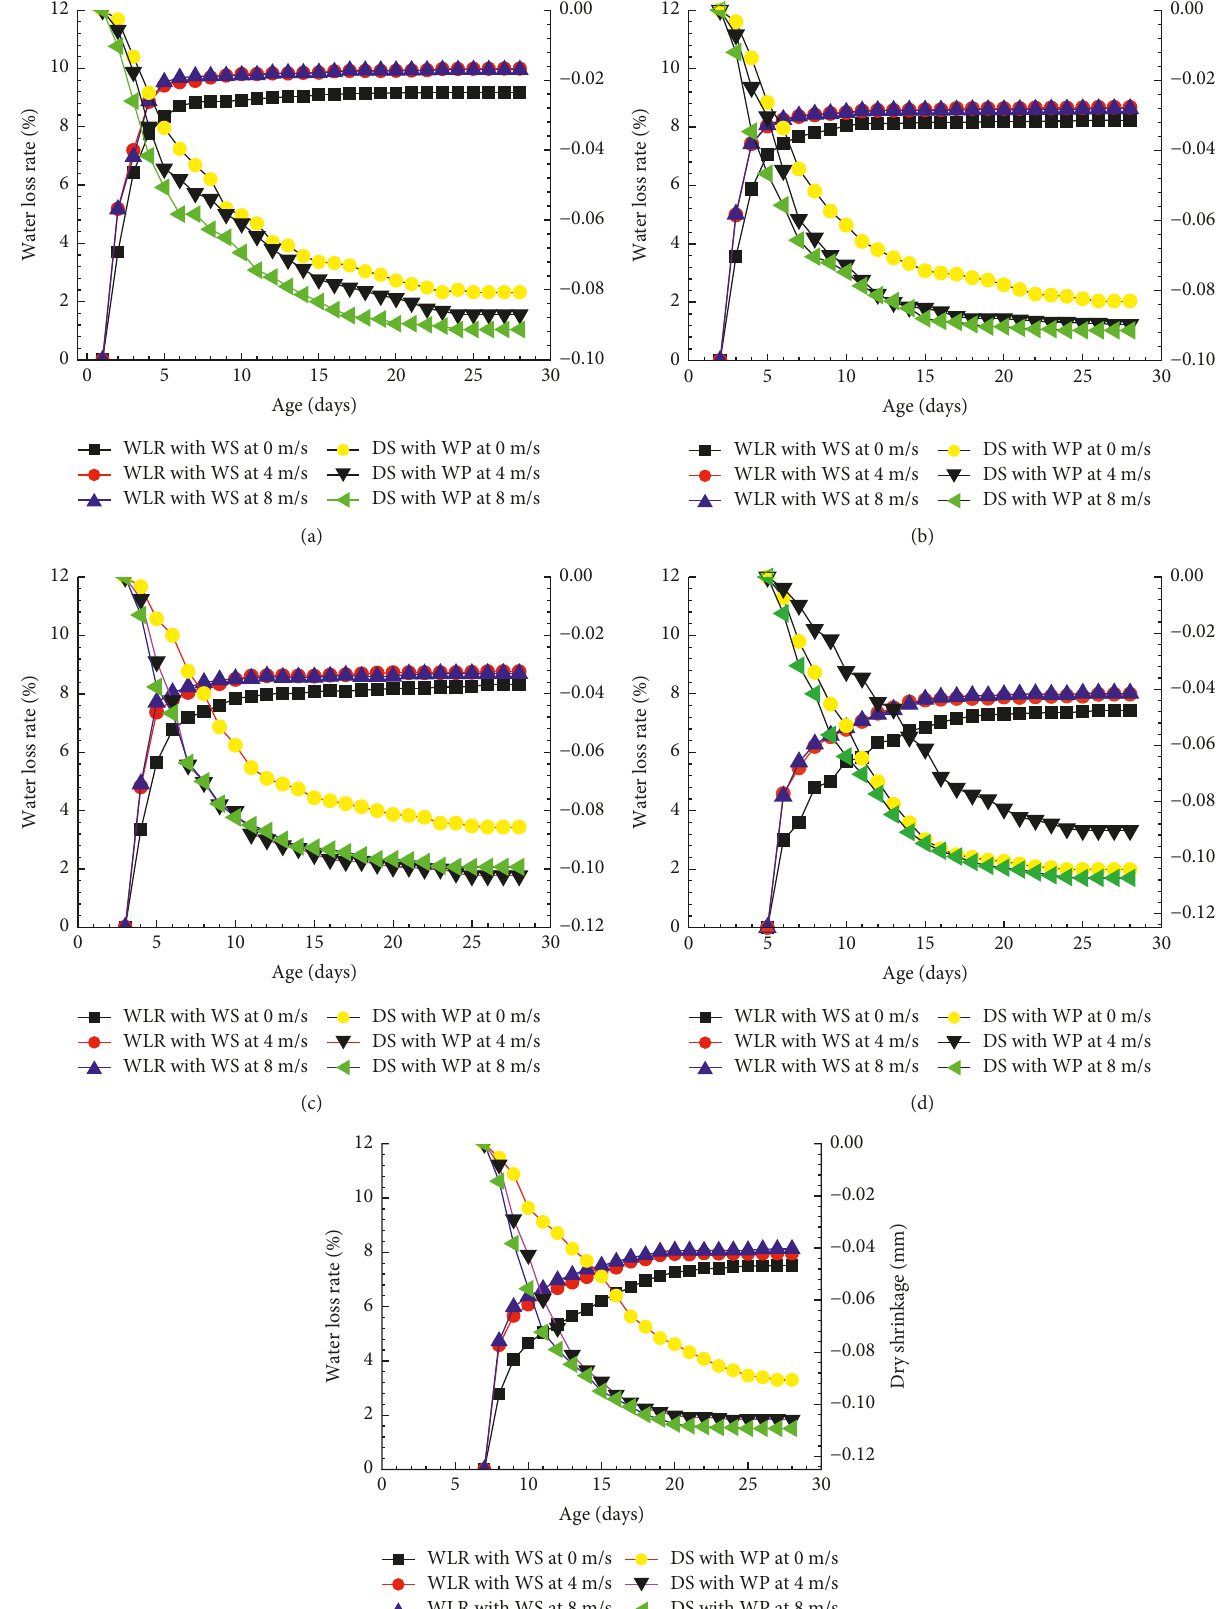
Figure 7: Water loss rate of DMPM with different moisture curing times. (a) 1 day. (b) 2 days. (c) 3 days. (d) 5 days. (e) 7